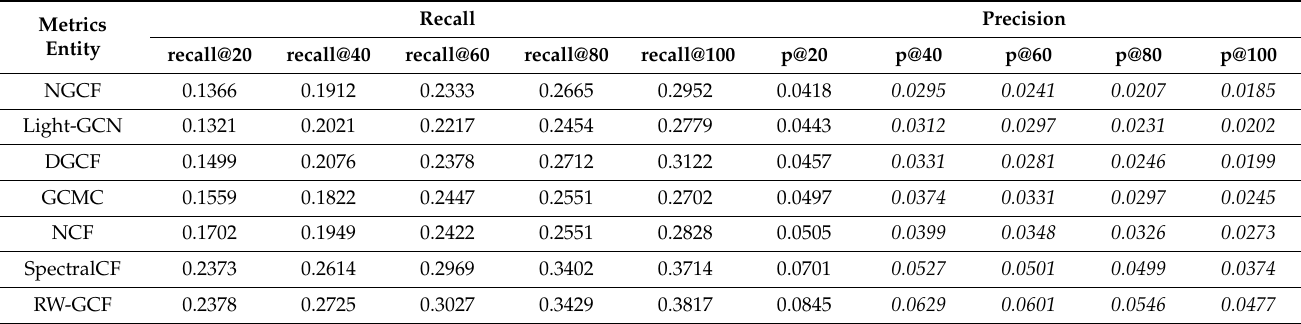
Table 2. Model Comparison: